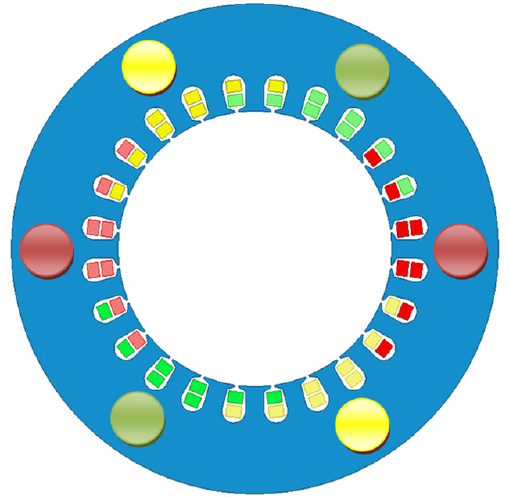
Figure 5. Three-phase winding distribution.